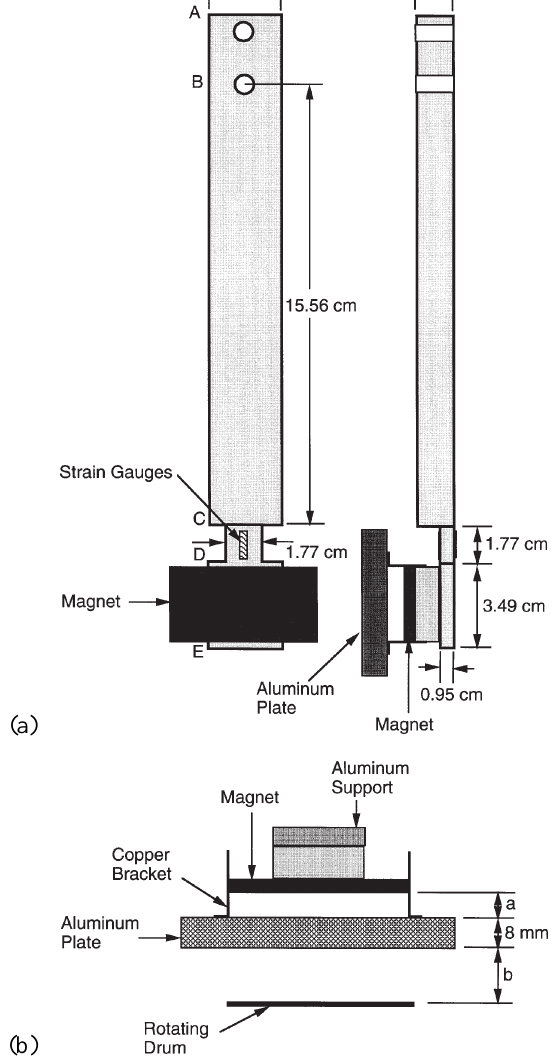
Fig. 2. Force transducer and magnet support: (a) overview, (b) active element.